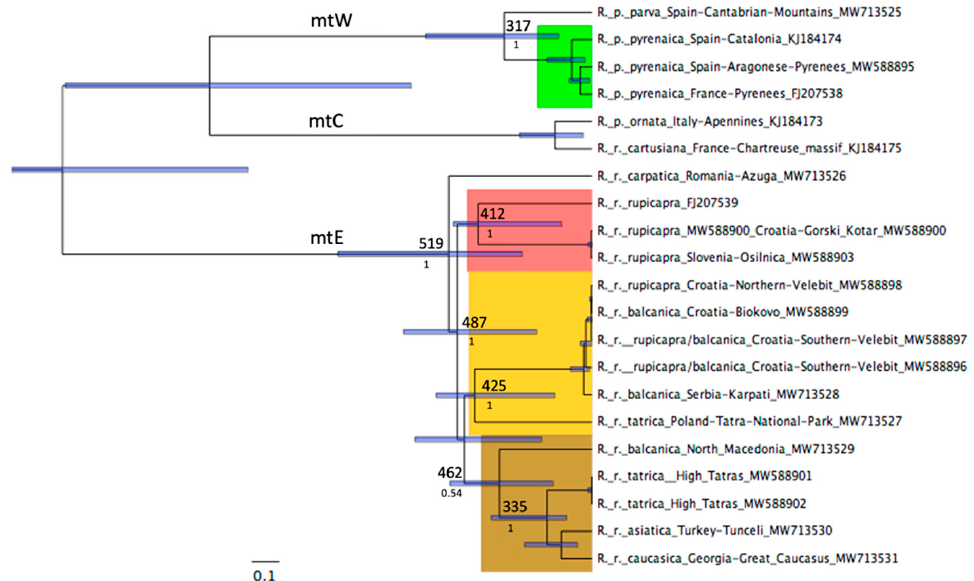
Figure 2. The Bayesian tree obtained with BEAST includes complete mtDNA sequences from the ten subspecies of chamois. The tree was rooted with Capra ibex (not shown). The Clades mtW, mtC, and mtE are indicated. The value above the subclade nodes corresponds to the mean age estimate of the nodes in thousand years, with 95% credibility intervals indicated by the blue bars. The Bayesian posterior probabilities are shown below the nodes. The colored rectangles highlight subclades within the main clades.